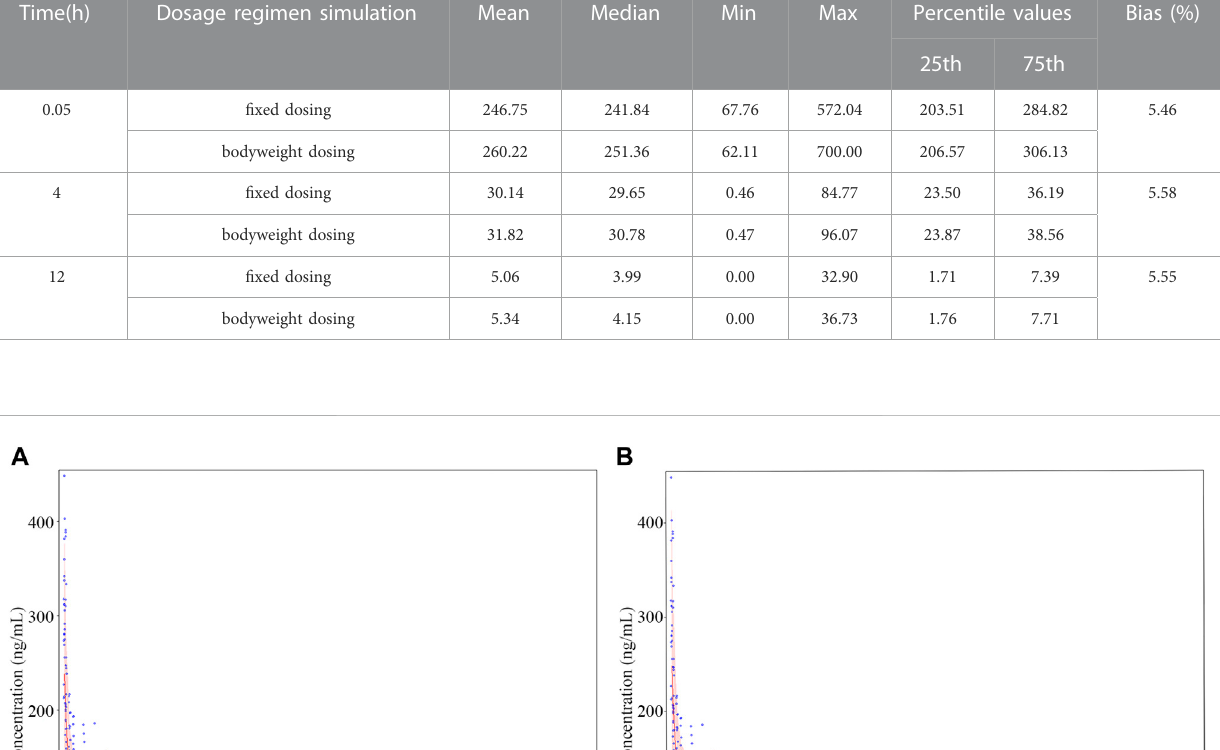
TABLE 6 Statistical analysis results of nalbuphine simulation on two dosage regimens. Time(h)